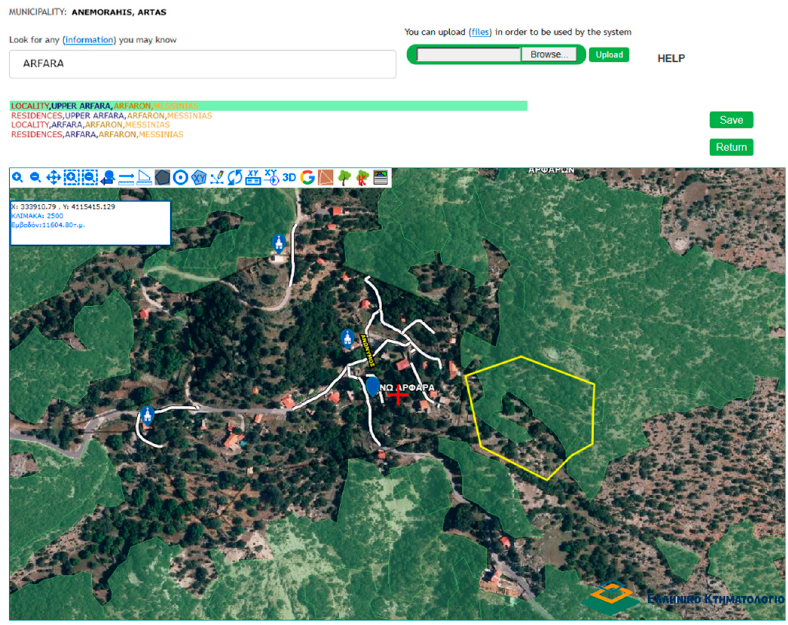
Figure 5. Both the final and temporary forest maps are available for display.